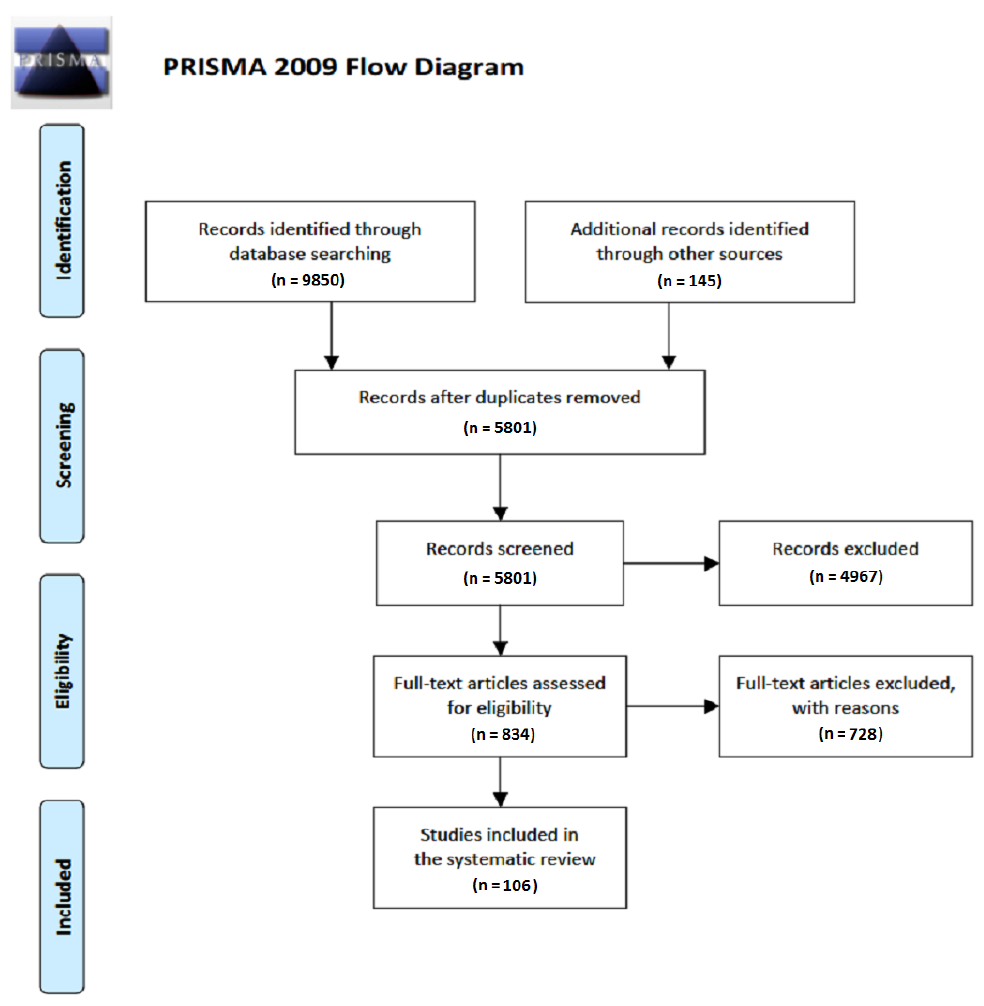
Figure A1. PRISMA Flow Diagram.